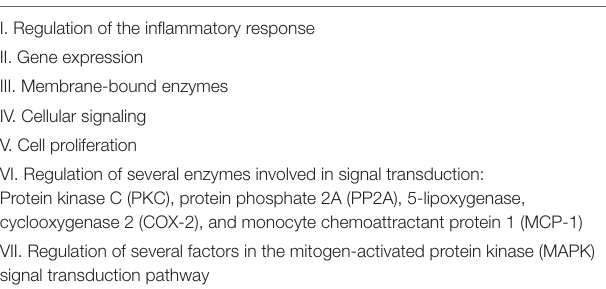
TABLE 2 | Activities influenced by vitamin E isoforms.